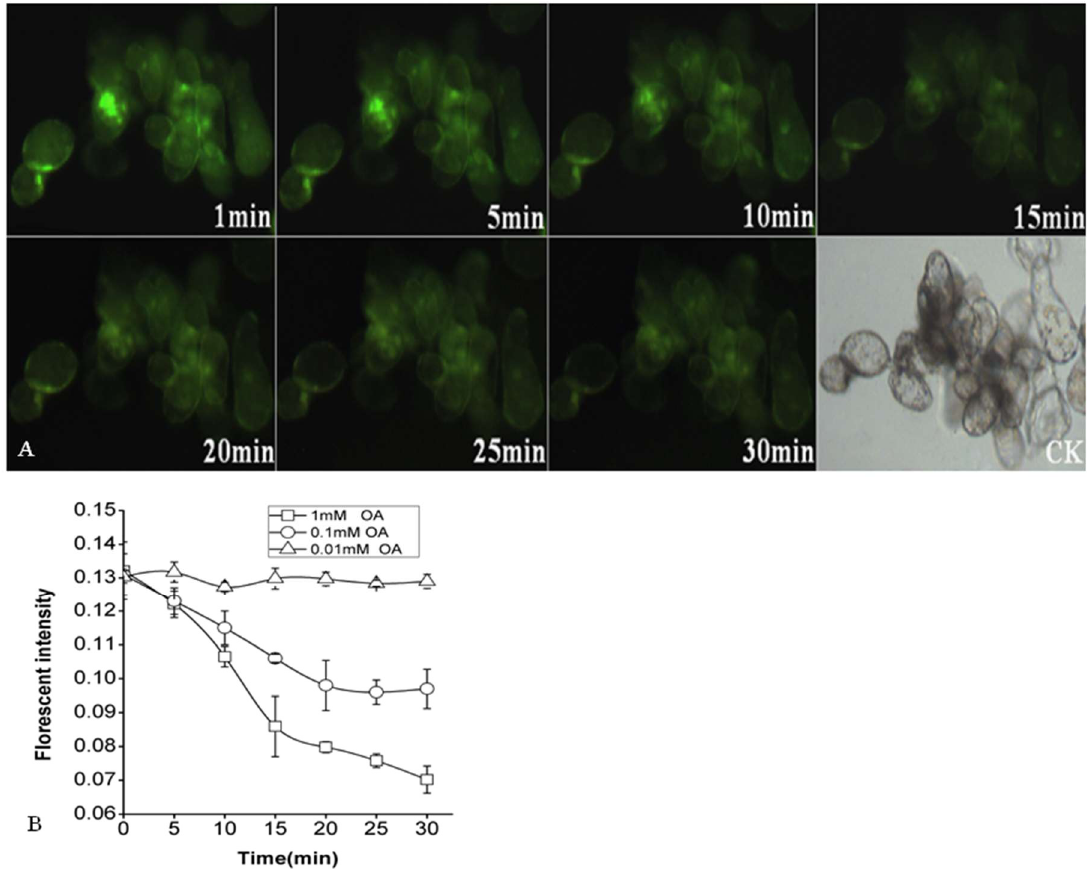
Figure 4. Effect of OA on P. tunicoides suspension cell pH cyt . Series of images of acidification in the cytoplasm after treating 1 mmol/L oxalic acid marked by BCECF-AM ( A ). Effect of different concentrations of OA on the pH cyt ( B ). Values are expressed as means ± SEM.